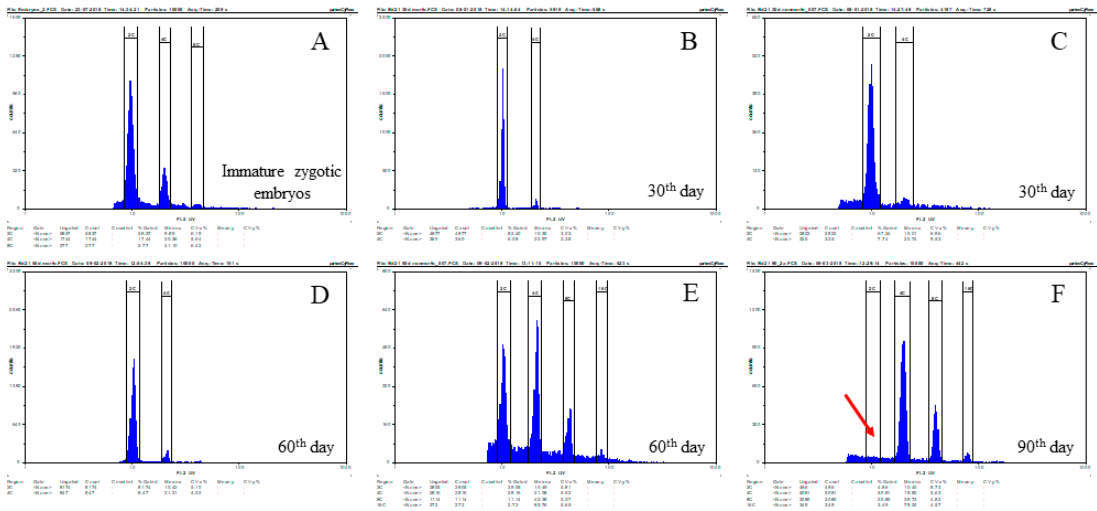
Figure 2. Relative DNA content determined by flow cytometry in zygotic embryos ( A ) and in B. distachyon callus on the 30th ( B – C , embryogenic and non-embryogenic parts, respectively), 60th ( D – E , embryogenic and non-embryogenic parts, respectively), and 90th ( F ) day of cultivation. The red arrow demonstrates the absence of 2C DNA on the 90th day of cultivation.